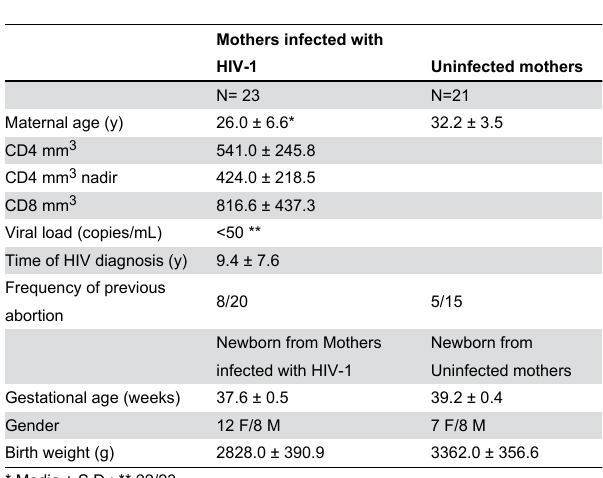
Table 2. Demographic details of the mothers and newborn.